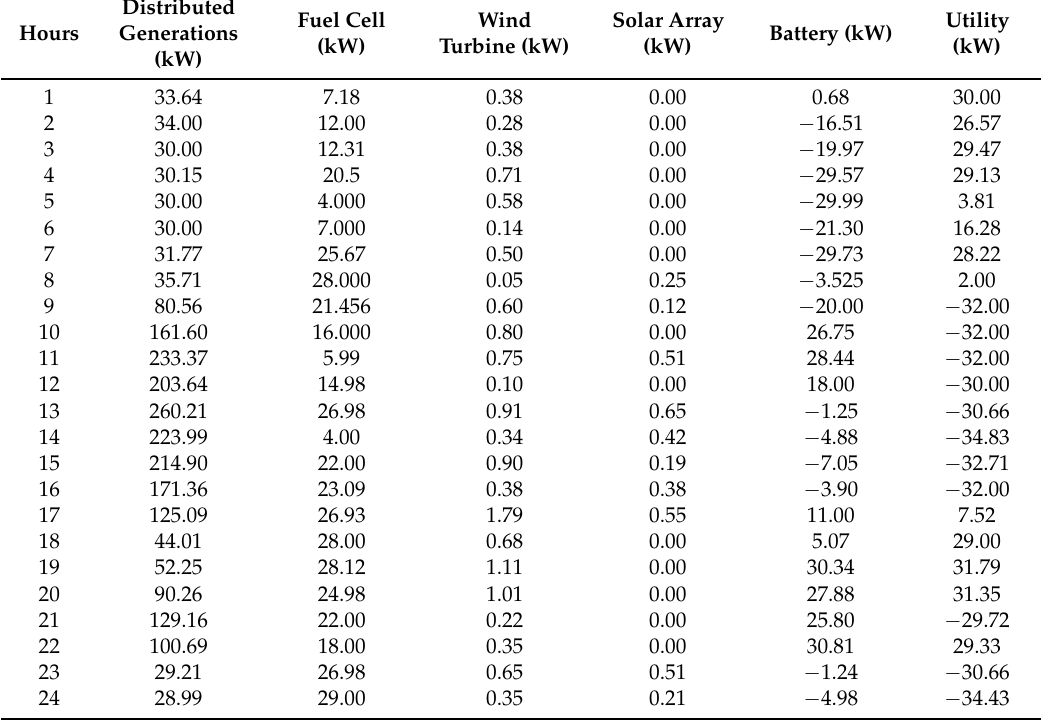
Table 2. Operating cost optimization of different energy generating units with DRPs.